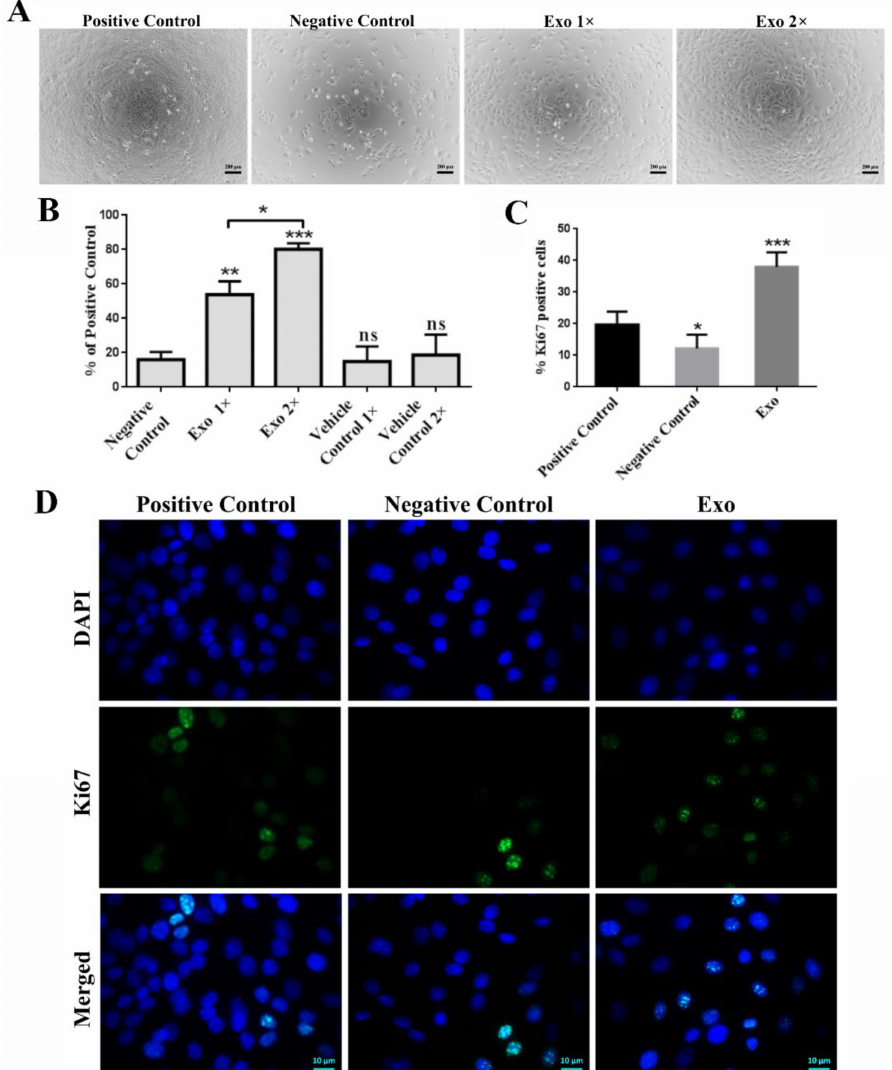
Figure 3. Exosomes enhance the proliferation of HaCaT keratinocytes. ( A ) Phase-contrast microscopy images of the exosomes-treated cells versus controls. ( B ) Assessment of keratinocytes viability by XTT assay performed after 3 days of incubation with two exosomes (Exo) concentrations (1 × and 2 × ). ( C ) Graph showing the quantification of Ki67-positive cells from the total number of cells from each condition resulting from the fluorescence microscopy analysis of keratinocytes grown for 3 days in serum-supplemented medium (positive control), serum-free medium (negative control), and serum-free medium supplemented with exosomes ( D ). Data are means ± SD ( n ≥ 3), * p < 0.05; ** p < 0.01, *** p < 0.001, ns—not